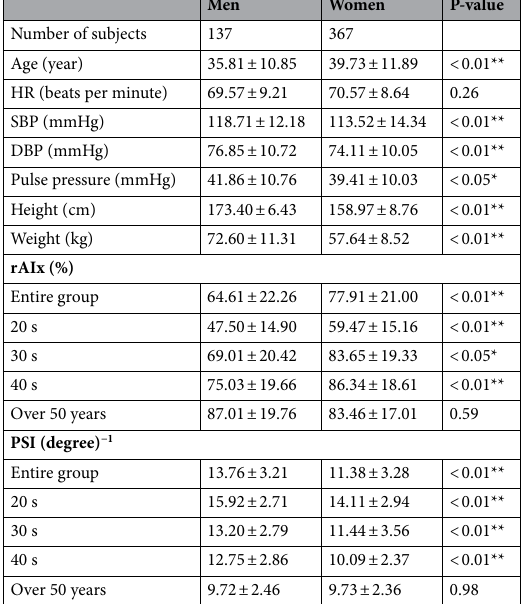
Table 1. Baseline characteristics and sex differences in the rAIx and PSI in each age group (mean ± SD). *P < 0.05; **P < 0.01. In the case of height and weight, there were no data in one clinical trial (IRB No. KOMCIRB-2014-70), so the values were calculated only from the data of the other five clinical